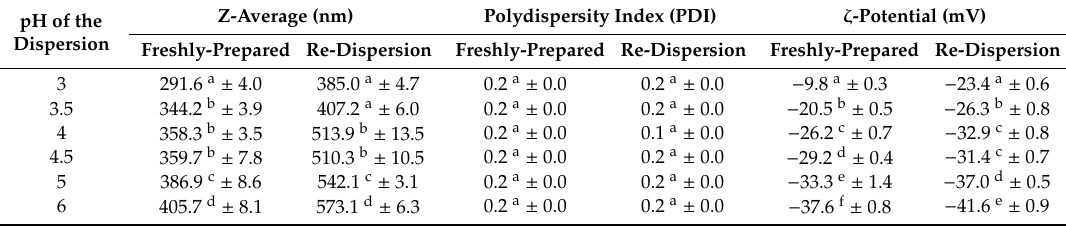
Table 1. Characteristic data of zein-caseinate-pectin particles before and after lyophilization. Z-Average (nm) Polydispersity Index (PDI) ζ -Potential pH of the Dispersion